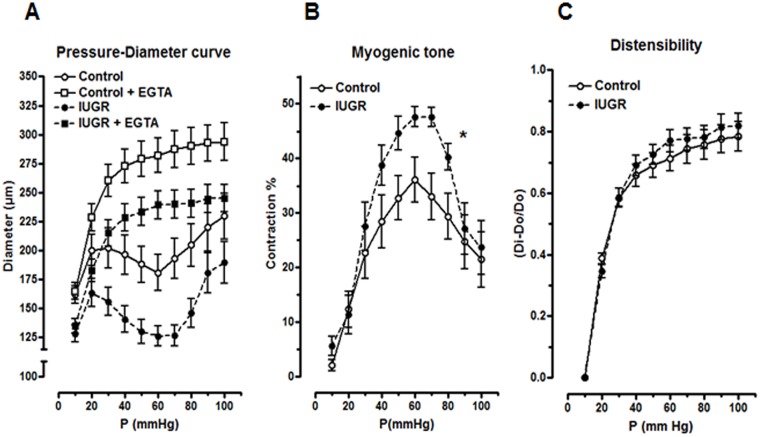
Myogenic responses of radial uterine artery supplying a placenta from control and IUGR 22-day pregnant rats.(A) pressure-diameter relationship, (B) myogenic tone and (C) distensibility. Results are expressed as means ± SEM from 18 blood vessel segments from 9 rats/group. * P<0.05, two-way ANOVA vs. control pregnant rat. Di: internal diameter at a given pressure. Do: original diameter measured at 10mmHg.